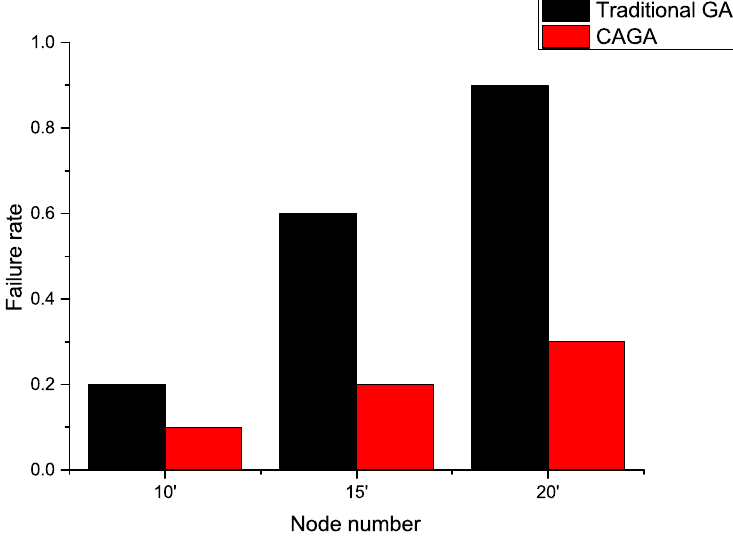
Figure 13. Robustness performance comparison.